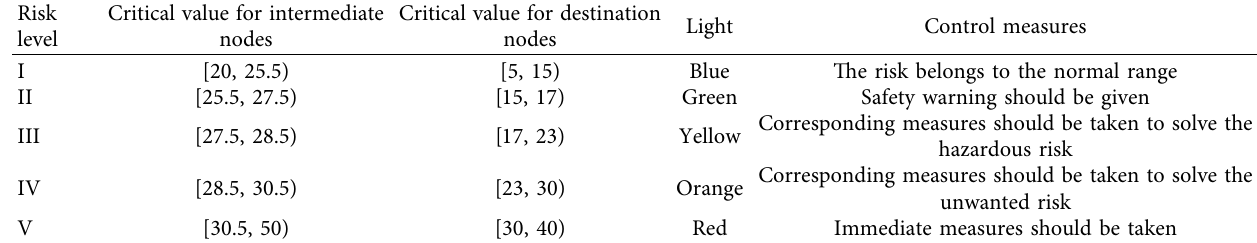
Table 4: Warning intervals.